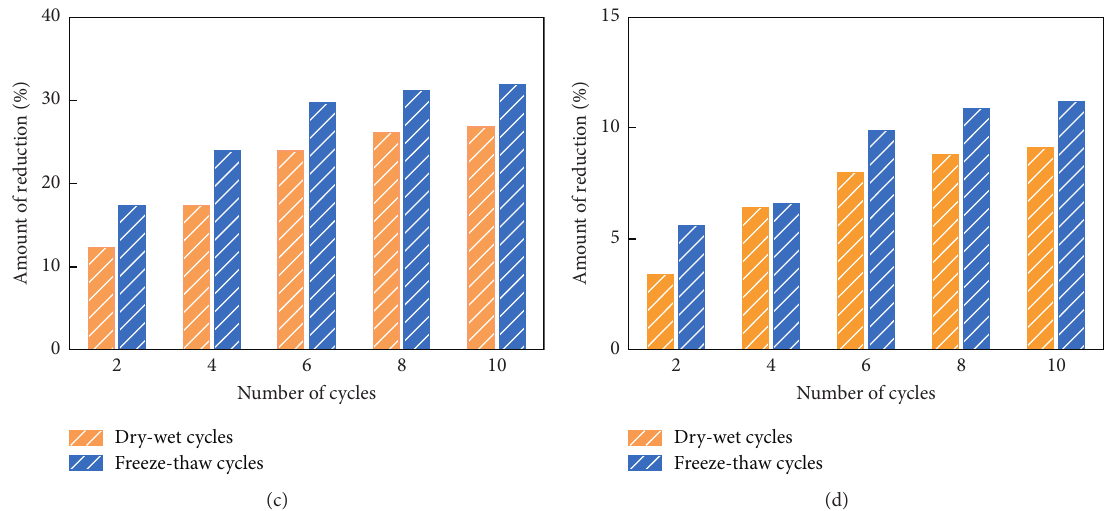
Figure 10: The effects of D-W cycles and F-T cycles on the reduction of antierosion ability parameters: (a) cohesion; (b) internal friction angle; (c) average disintegration rate; (d) permeability coefficient.